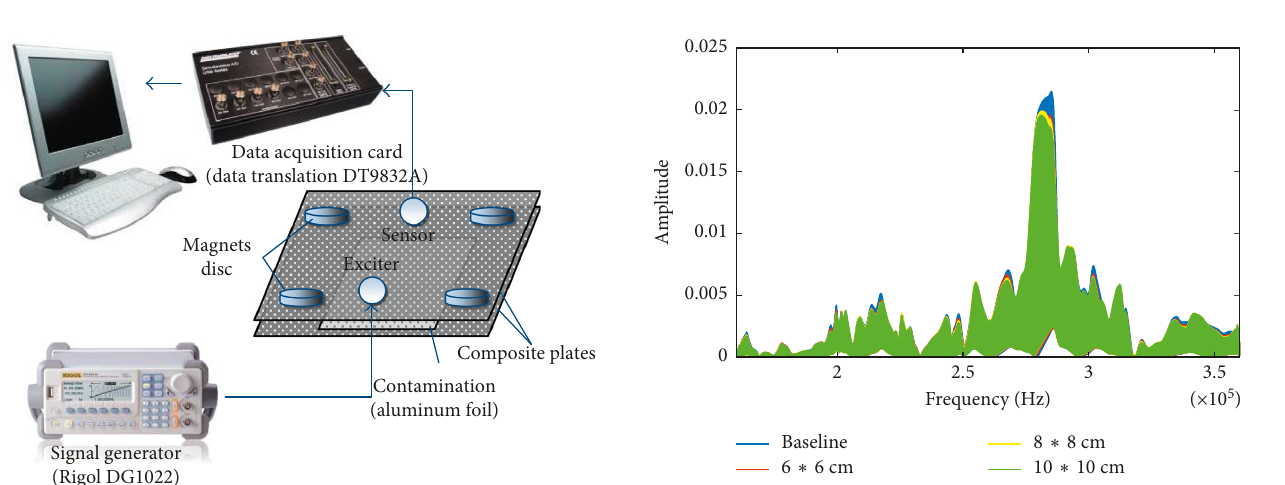
Figure 3: Comparing FFT results between different levels of simulated contamination in the heterodyne method.